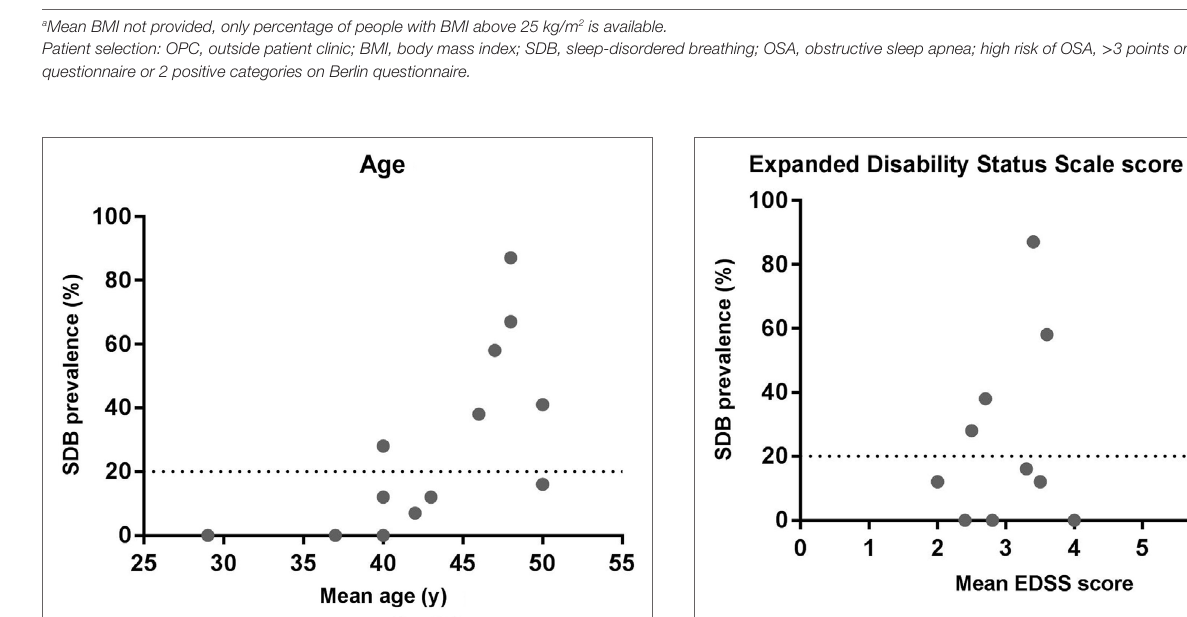
FigURe 1 | Relationship between sleep-disordered breathing (SDB) prevalence and age. The data show the prevalence of SDB and the mean age from the studies listed in Table 1 .